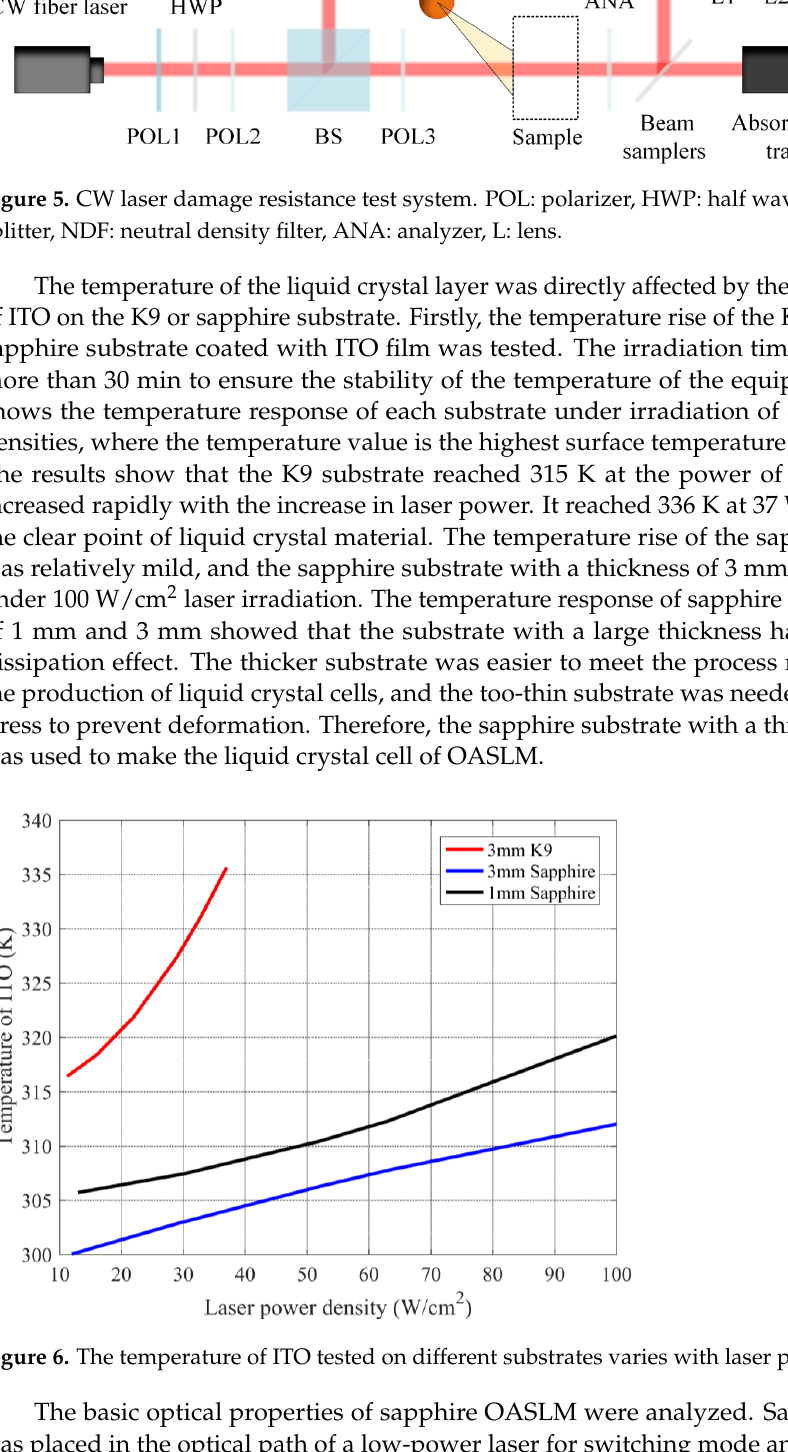
6 of 12 Figure 4. ( a ) Schematic diagram of bilateral sapphire OASLM structure. ( b ) Temperature distribu- tion of bilateral sapphire OASLM. ( c ) Temperature curve along the x -axis of each layer structure. 3. Experimental Results and Discussion The experimental device for the laser damage resistance test is shown in Figure 5. The laser adopted a power-adjustable fiber CW laser with a maximum output power of 500W, and the central wavelength was 1064 nm. The sample to be measured was placed in the dotted box, and the spot diameter on the sample was 8 mm. The thermal imager is FLK-Ti400+, produced by Fluke. Because the temperature distribution inside the liquid crystal layer cannot be measured directly in the experiment, the temperature distribution on the surface of the irradiated substrate was detected by a thermal imager. The OASLM used was an amplitude operation mode, so two parallel polarizers were set in the front and back, and the polarization direction was perpendicular to the horizontal line. The op- tical aperture of OASLM equipment is 22 × 22 mm, with 720 × 720 pixels. They were cali- brated through the calibration program [32]. The switching ratio under low-power laser